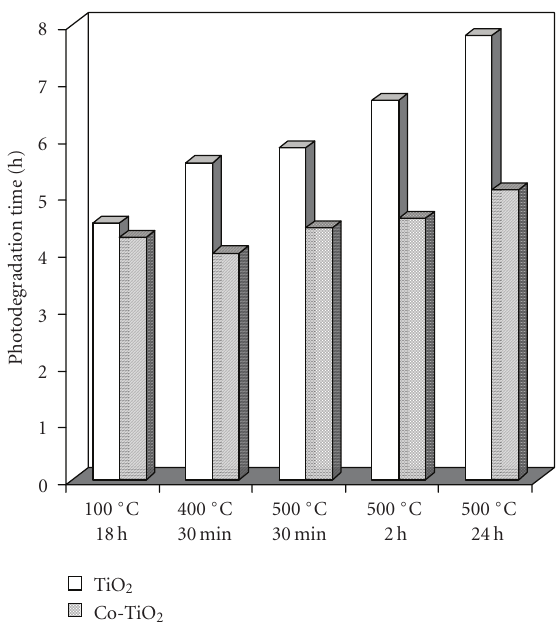
Figure 5: E ff ects of the calcination time and temperature on the time required for the photodegradation of 1mM 4-chlorophenol in aqueous suspensions of TiO 2 and Co( x %)-TiO 2 , where the degree of doping ( x %) is